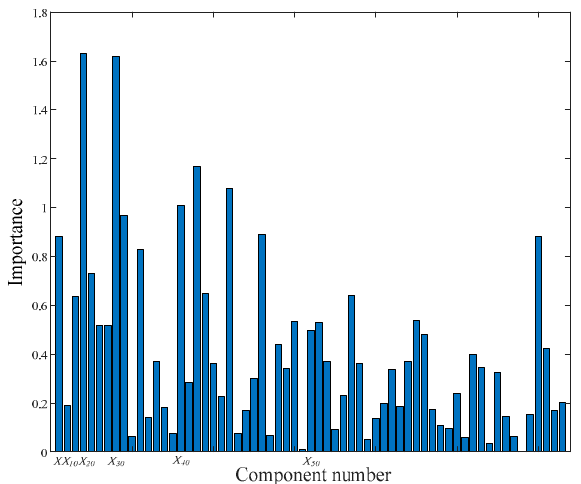
Figure 22. The mean classification accuracy and computation time using HLZC with different k .